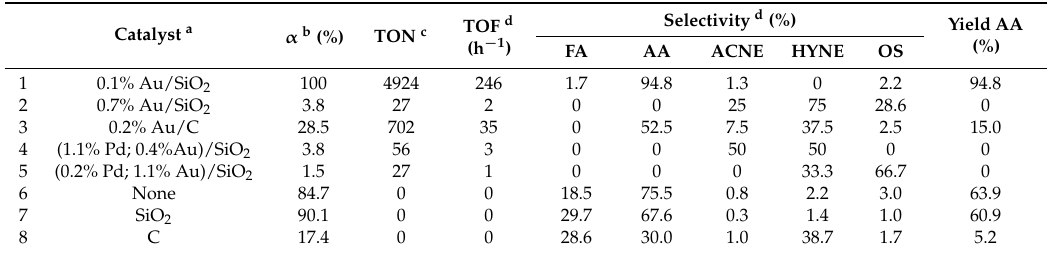
Table 4. Catalytic performance of the resulting catalysts in the oxidation of 1,2-propanediol into acetic acid under reaction conditions as described in Experiment